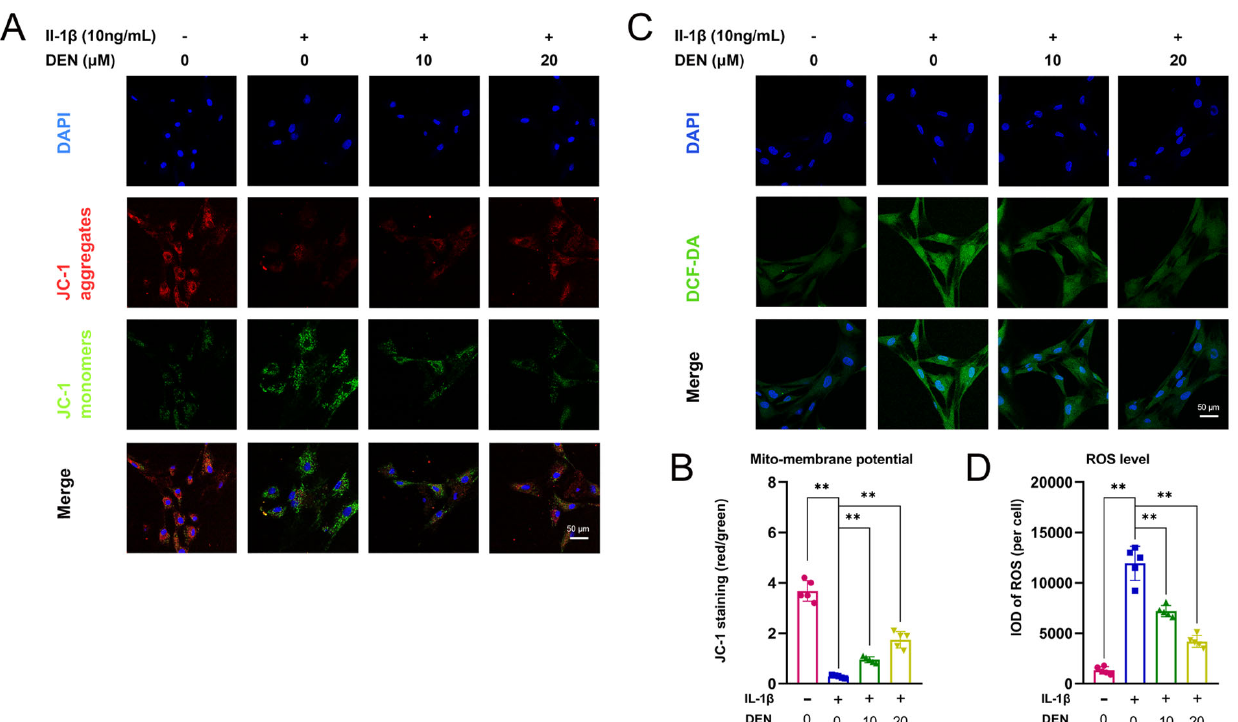
Figure 4. Effects of dendrobine (DEN) on mitochondrial membrane potential and reactive oxygen species (ROS) levels in IL-1 β -induced chondrocytes. ( A , B ) The mitochondrial membrane potential was measured by JC-1 assay, n = 5. ( C , D ) The ROS level in chondrocytes was measured using a ROS assay kit, n = 5. The values presented are the means ± SD. ** p < 0.01.